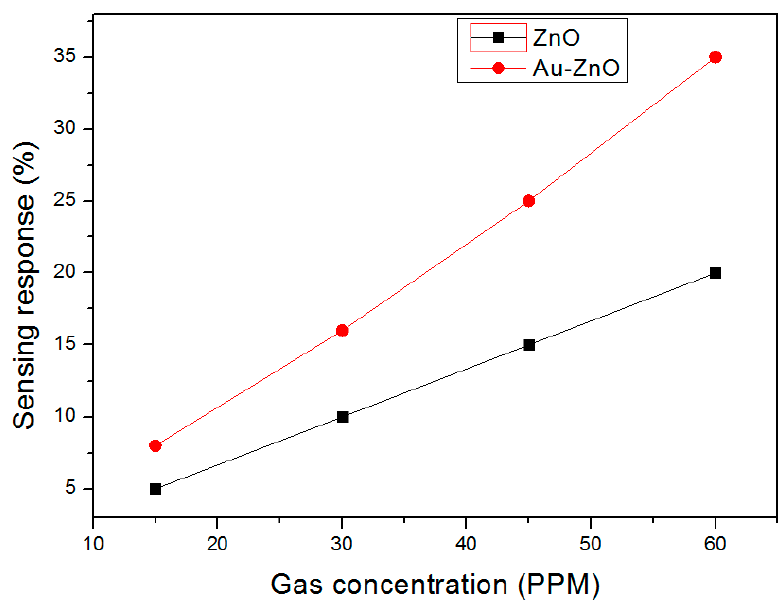
Figure 10. Gas concentration vs. sensing response graph.